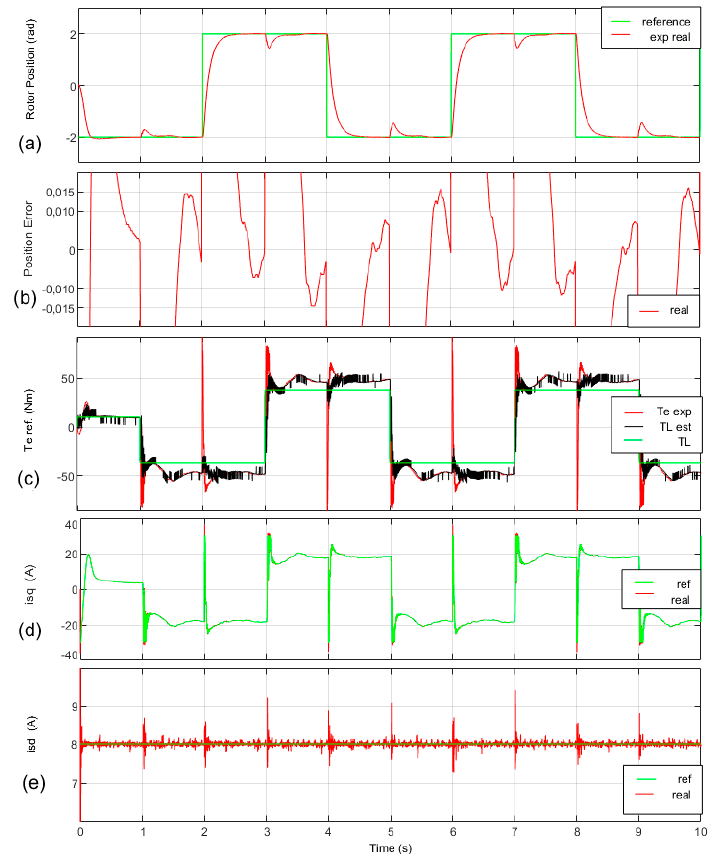
Figure 8. Experimental test employing the D2 design for the IM machine: ( a ) rotor position, reference and real (rad); ( b ) rotor position error (rad); ( c ) rotor position error zoom (rad); ( d ) electromagnetic torque (Te), estimated load torque (TL est) and load torque (TL), (N · m); ( e ) torque current, isq (A) and ( f ) rotor flux current, reference and real, isd (A).